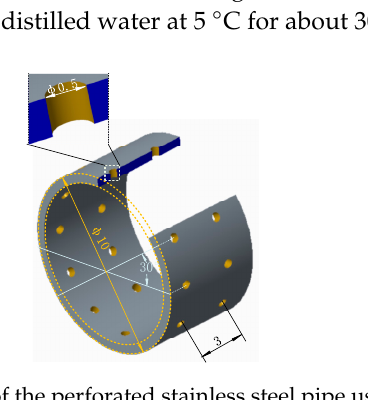
Figure 5. Geometric parameters of the perforated stainless steel pipe used as an extruding mold.